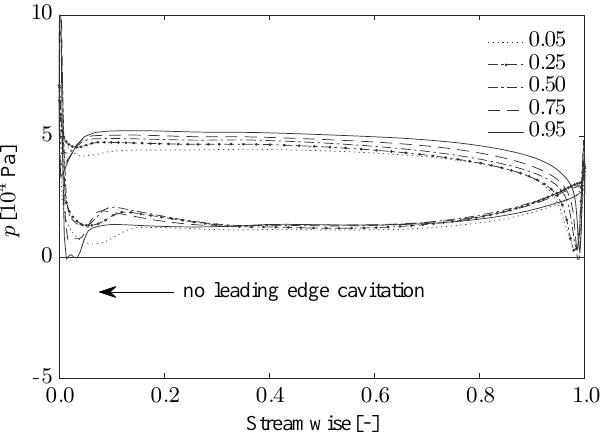
Fig. 6. Pressure on blades of the final runner at different